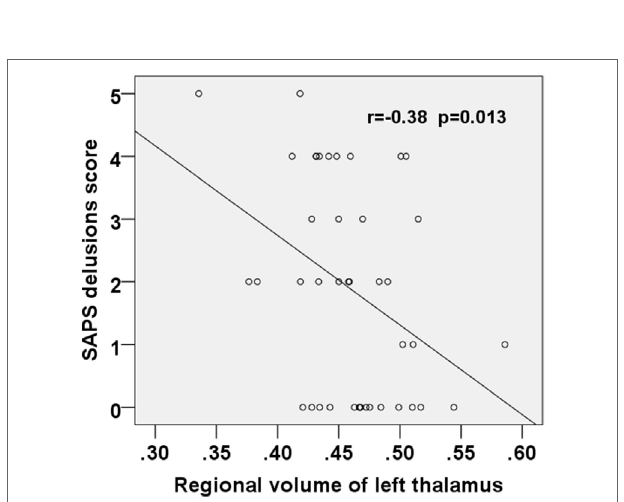
FigUre 4 | Scatter plot showing negative correlation between the SAPS delusions score and the regional volume of the left thalamus in the first-episode schizophrenia patients. SAPS, Scale for the Assessment of Positive Symptoms.